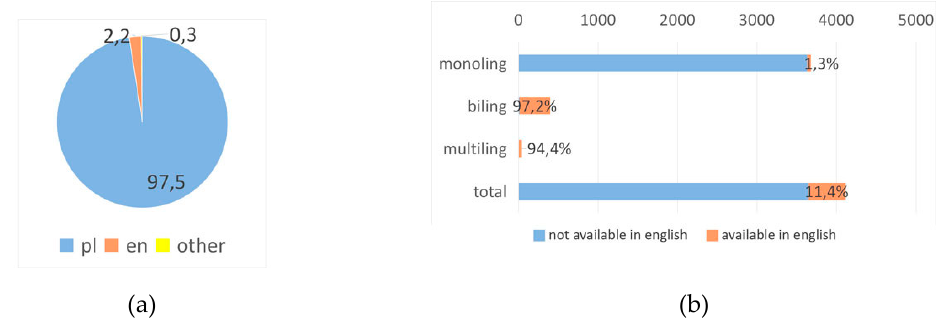
Figure A21. Visualization of the results for domain pl. ( a ) Primary languages pie chart and ( b ) English language availability bar chart.